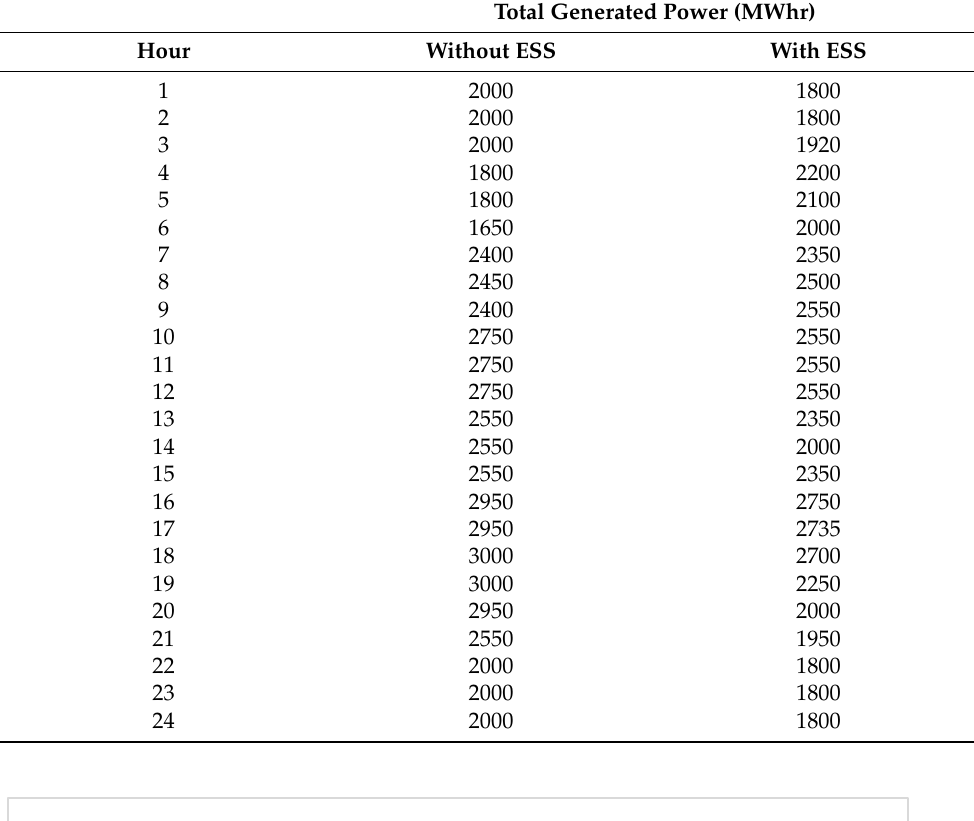
Table 2. Characteristics of load levelling being done in SG.